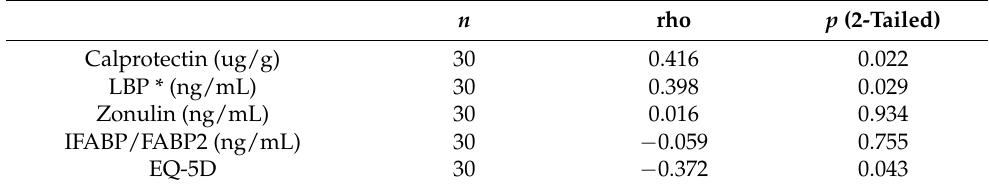
Table 3. Spearman’s correlation between patients’ health score and biomarkers and patients’ quality of life score.